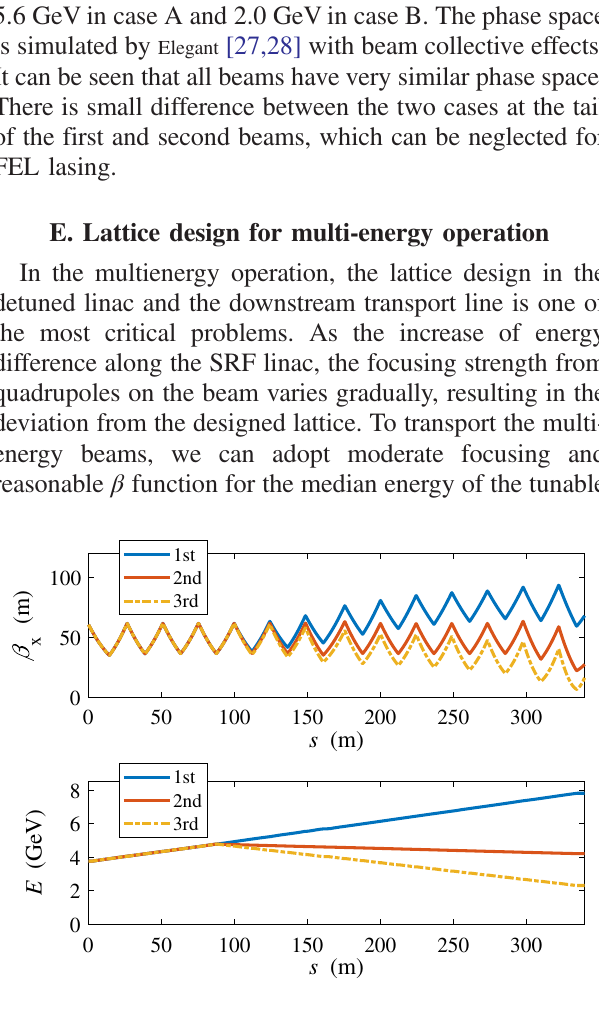
FIG. 10. The β x function (top) and energy evolution (bottom) in the detuned linac of the three electron beams of case B in Table. I in the